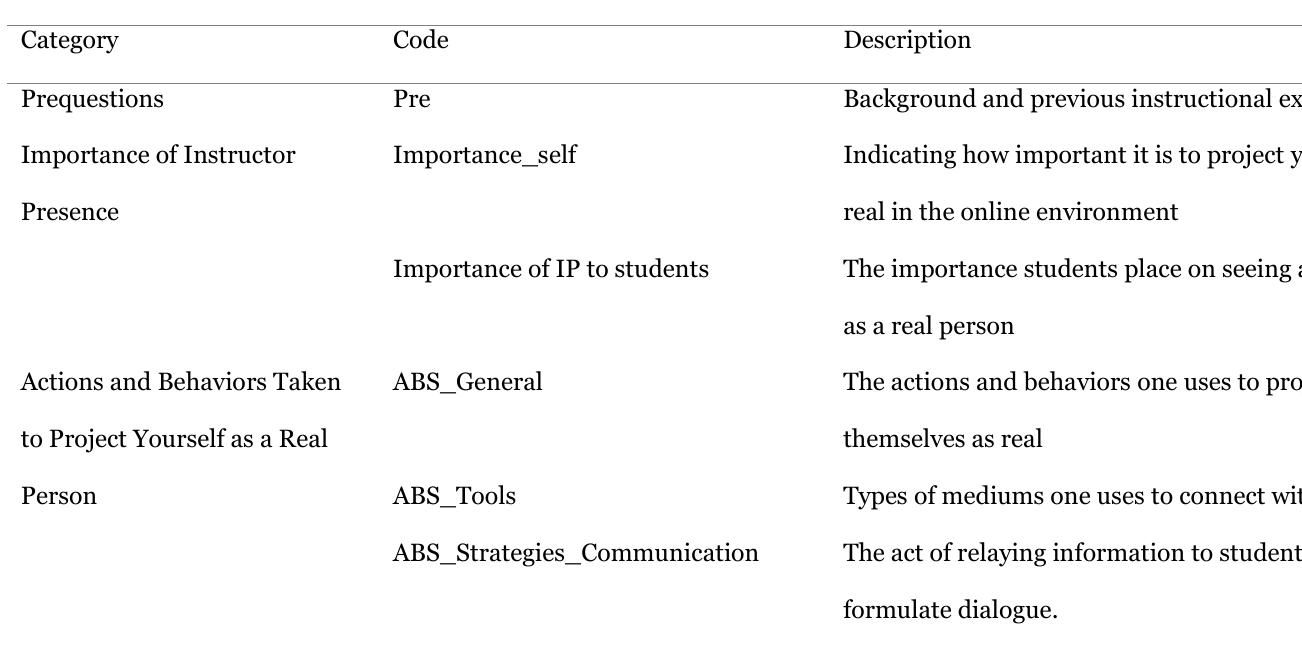
Table B1 Instructor Perceptions of IP Coding